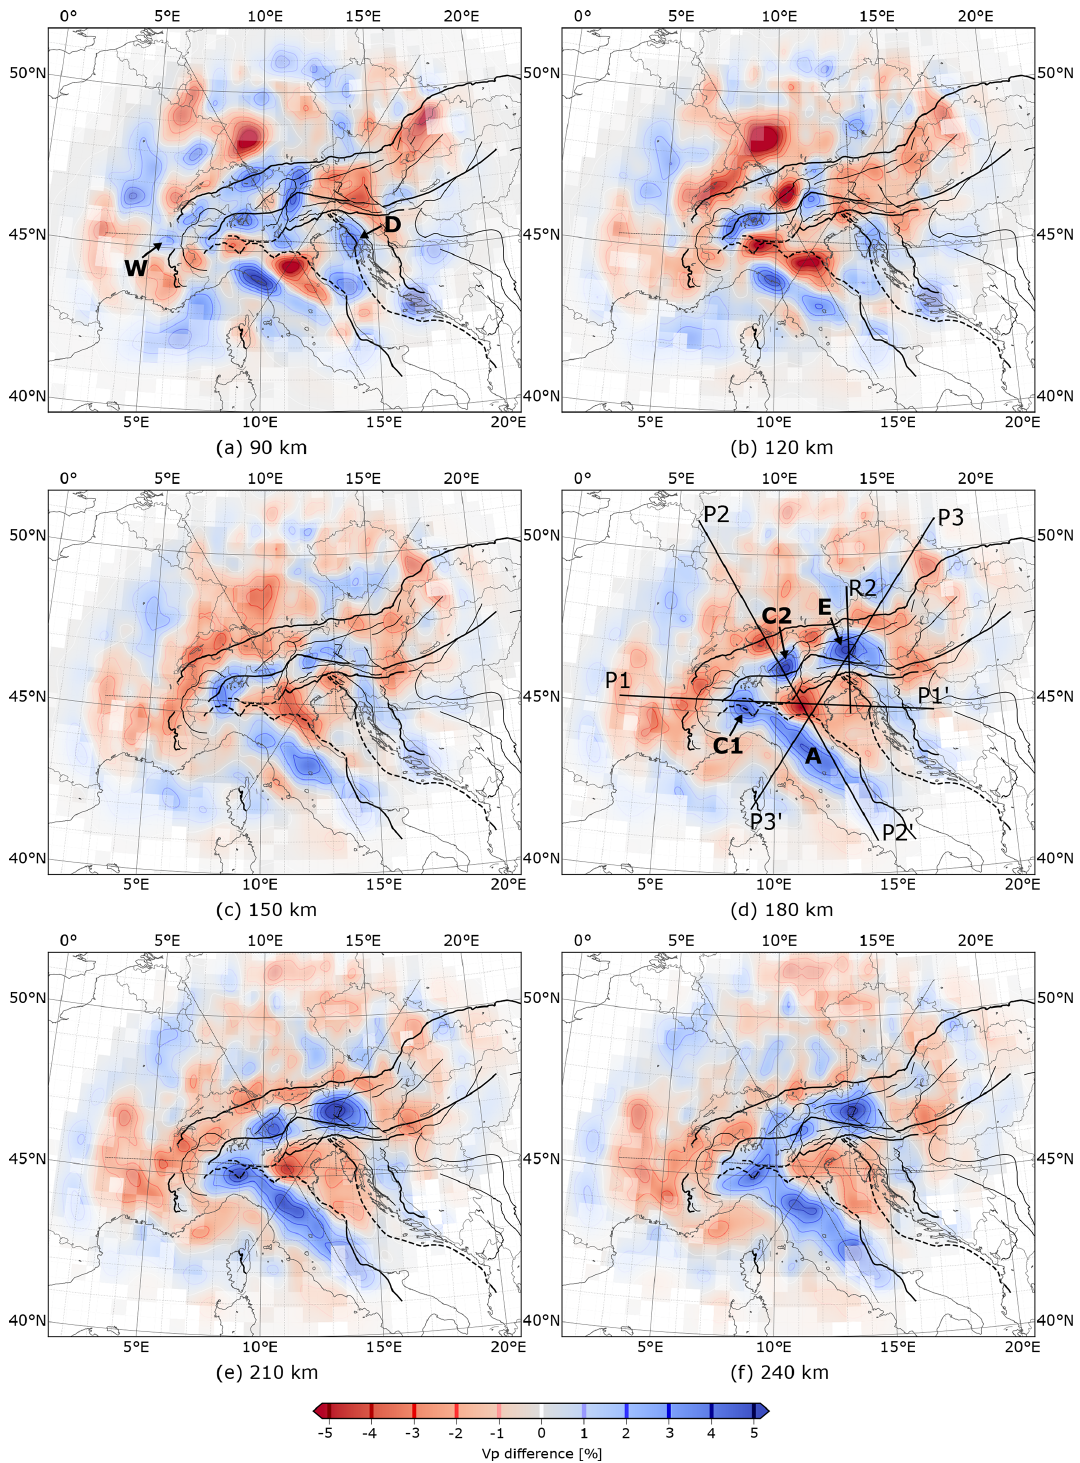
Figure 13. Horizontal slices through the resulting model. Traces of vertical profiles are indicated at 180km depth (and as thin grey lines on all profiles) where the major velocity anomalies can be seen best. Important anomalies discussed in the text are marked at 90 and 180km